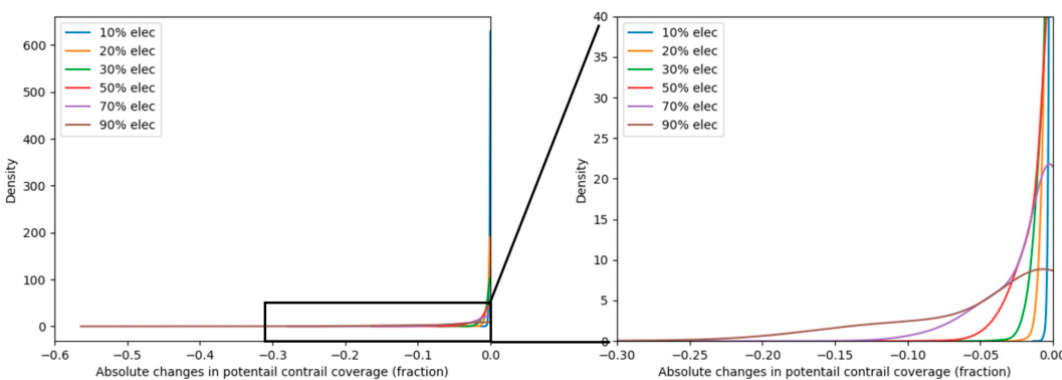
Figure 11. Distribution of the reduction in PCC with respect to different degrees of electric hybridization.